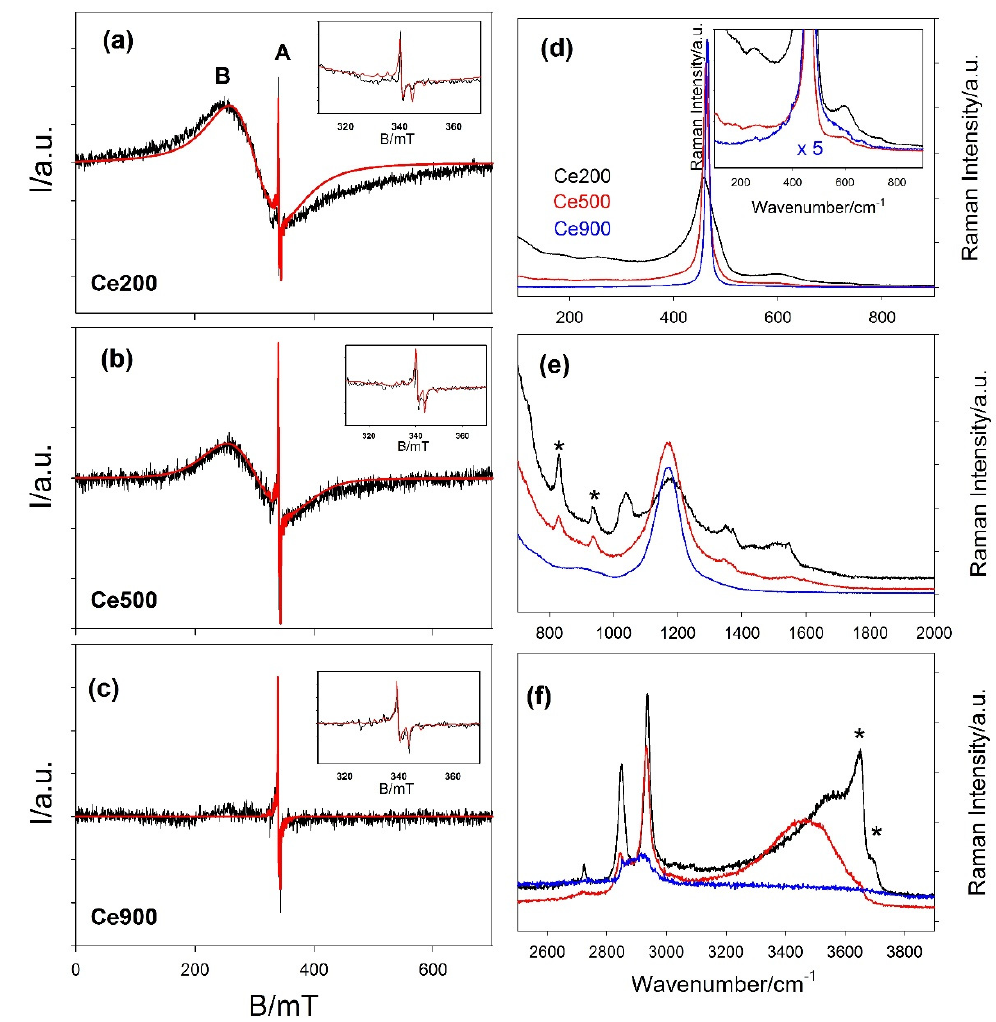
Figure 8. ( a – c ) Experimental ESR spectra collected at room temperature on the Ce200 (top), Ce500 (middle) and Ce900 (bottom) are reported as black curves. Features A and B are described in the main text. The detail of the A spectrum is reported in the insets. Spectral simulations realized by the model described in the main text are represented by red curves. ( d – f ) Raman spectra of Ce200 (black), Ce500 (red) and Ce900 (blue) in the ( d ) 200–900 cm − 1 , ( e ) 700–1900 cm − 1 and ( f ) 2500–4000 cm − 1 ranges. The insets highlight the less intense features of the same spectra. To this purpose, the blue curve has been multiplied by 5.